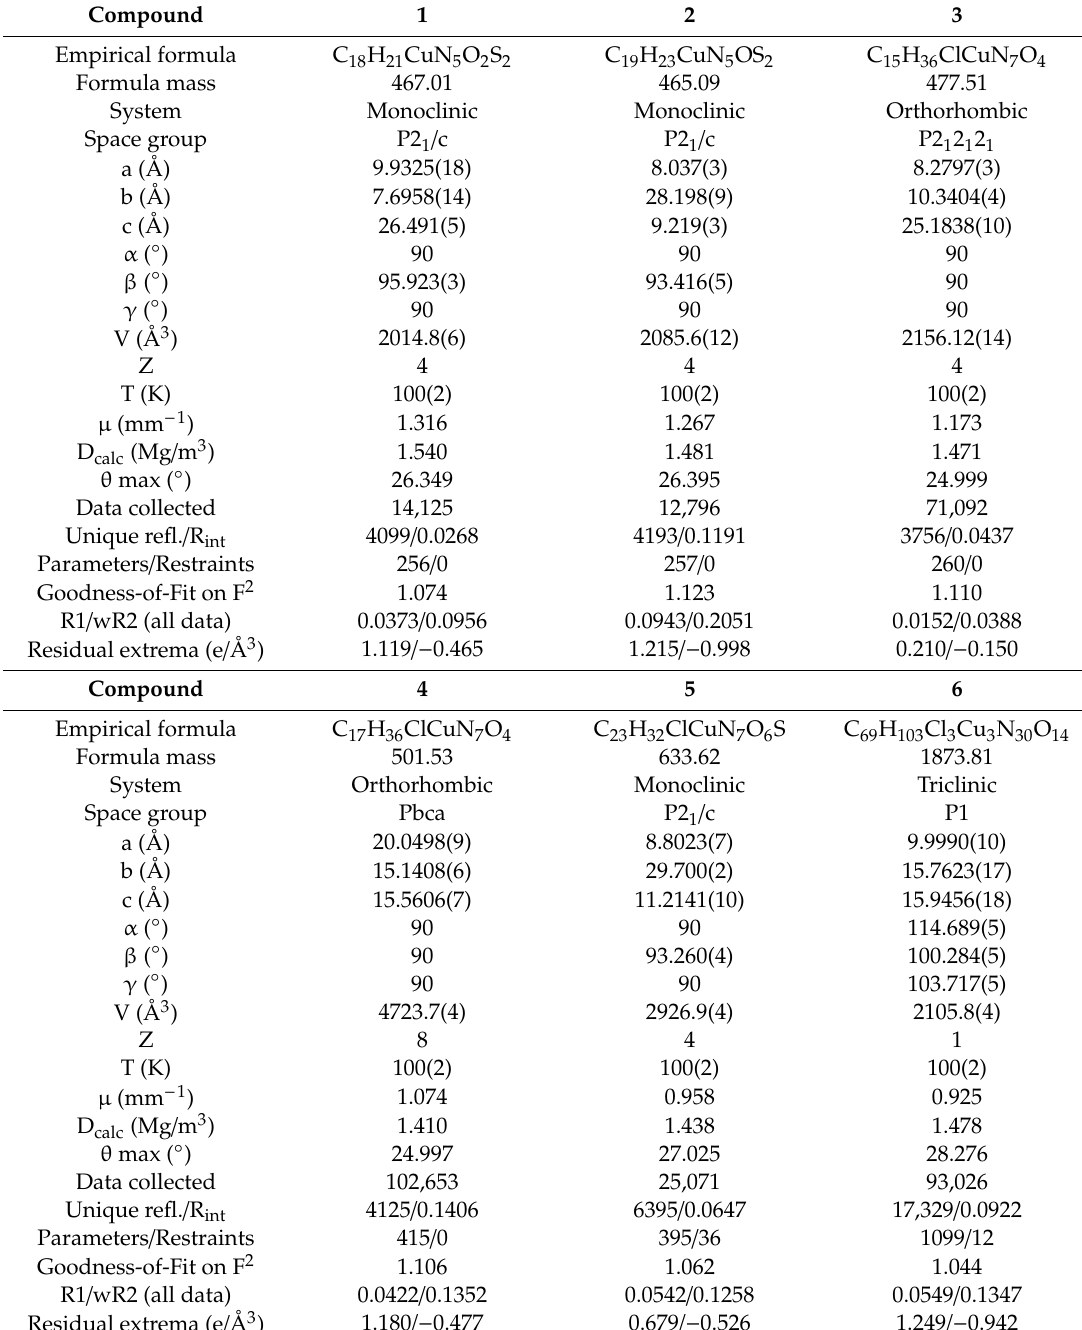
Table 4. Crystallographic data and processing parameters of 1 – 6